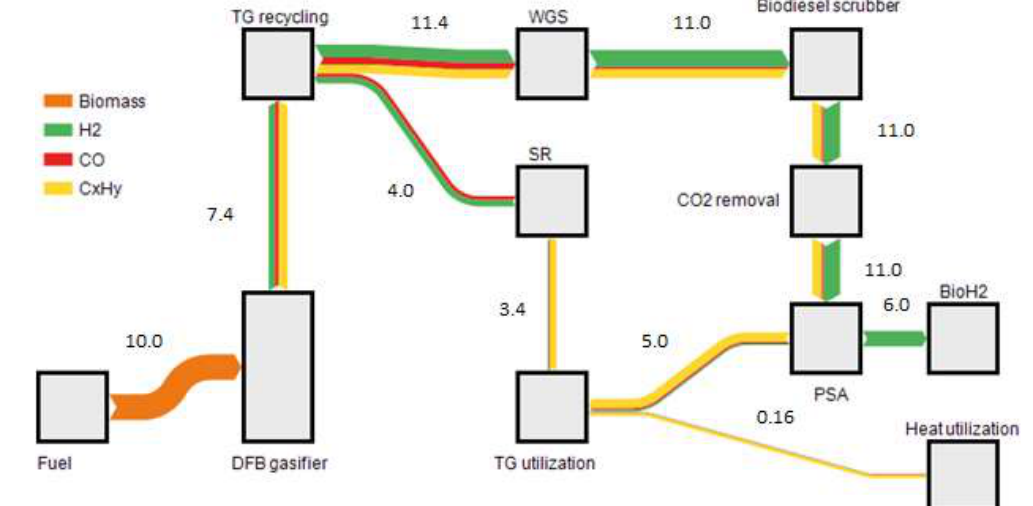
Figure 6. Sankey diagram of the energy balance for a 10 MW BioH 2 plant only illustrating the LHV based energy streams in MW.